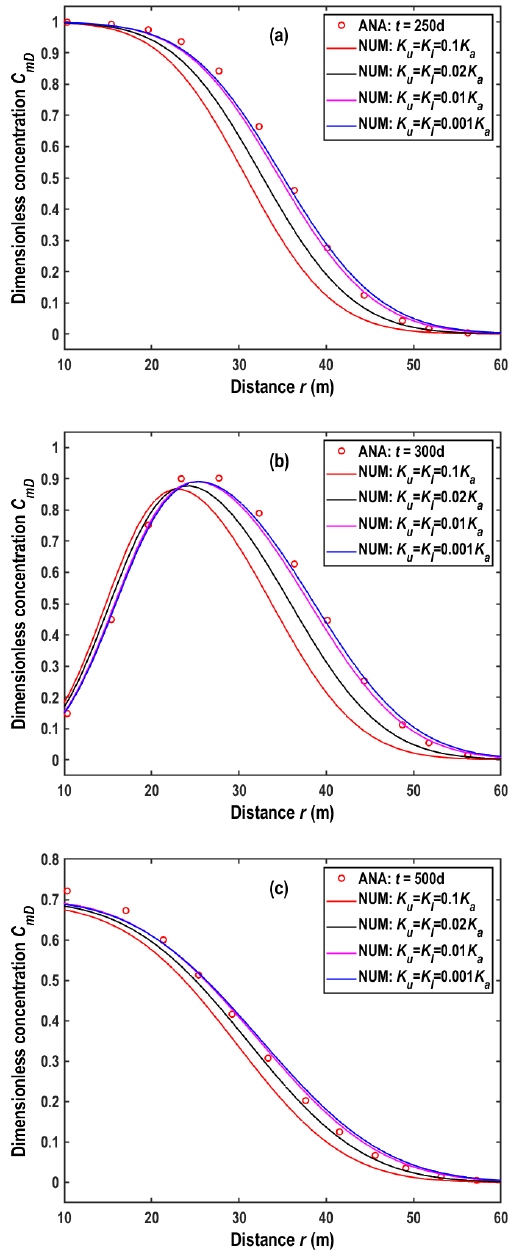
Figure 3. Comparison of the concentration distribution between the analytical and numerical solutions along the r axis at z = 0m. “ANA” and “NUM” represent the analytical and numerical solu- tions, respectively. (a) At the end of the injection phase: t = 250d. (b) At the end of the chasing phase: t = 300d. (c) In the extraction phase: t =